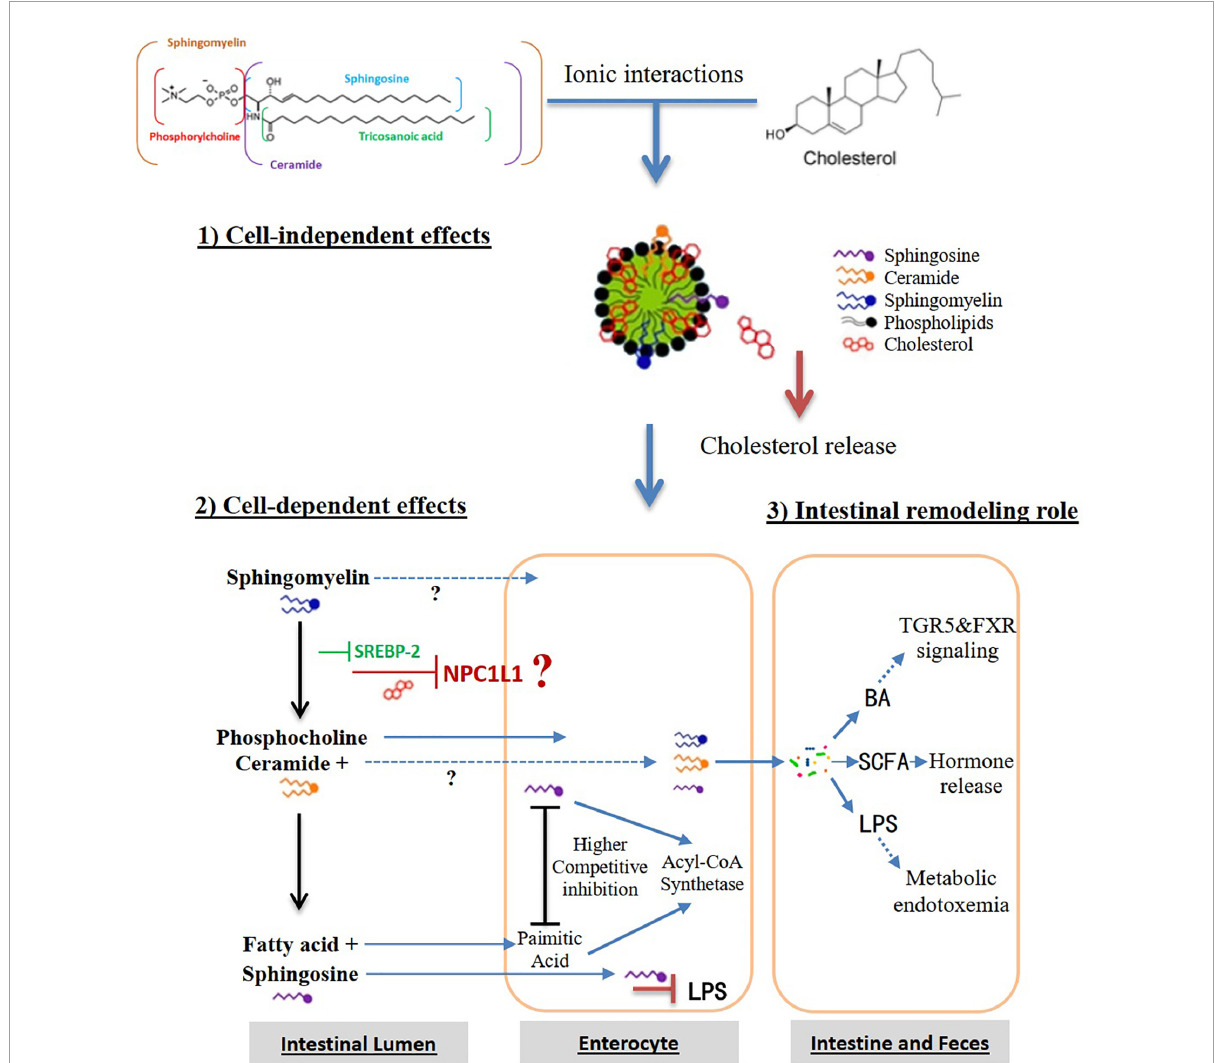
FIGURE4 Hypothesis that dietary sphingomyelin inhibits the intestinal cholesterol absorption pathways. Alk-SMase, alkaline SMase; SREBP-2, sterol regulatory element-binding protein-2; NPC1L1, Niemann-Pick-Like Protein 1; N-CDase, neutral ceramidase; LPS, lipopolysaccharide; BA, bile acid; TGR5, Takeda G protein-coupled receptor 5; FXR, farnesoid X receptor; SCFA, short-chain fatty